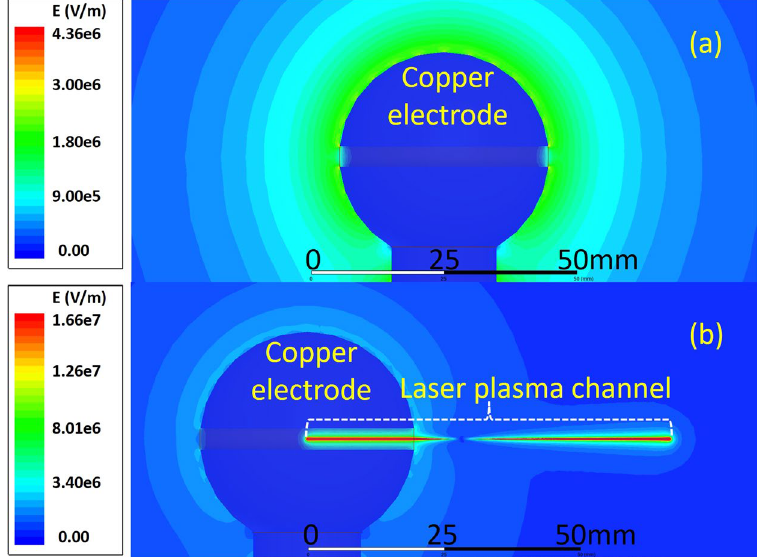
Figure 6. Electric field distribution around the spherical electrode when a high voltage of 50 kV was used ( a ) without laser plasma channel and ( b ) with laser plasma